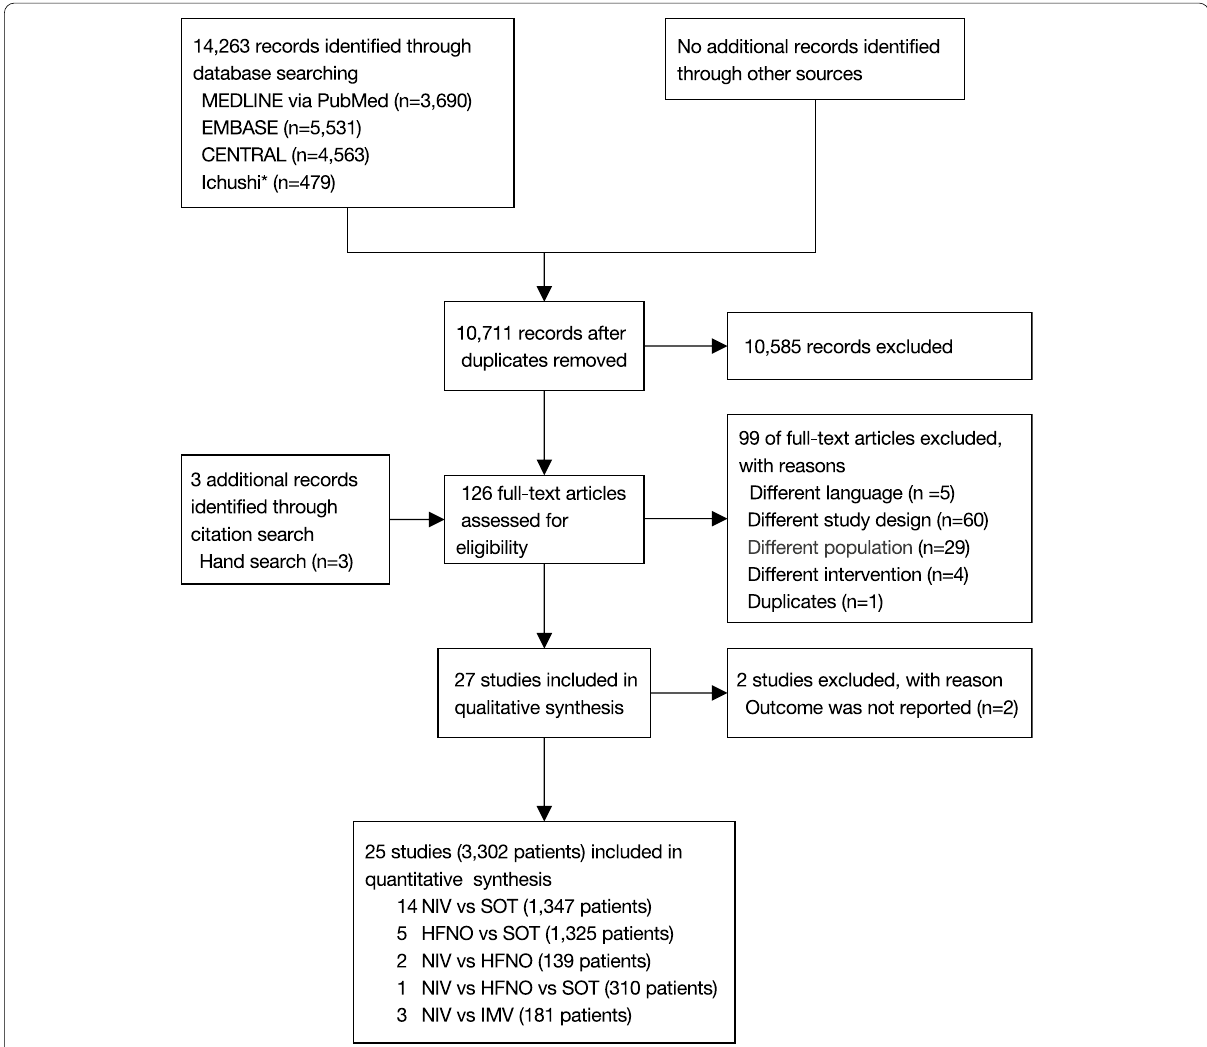
Fig. 1 Flow diagram for the studies included in this review. * Ichushi is a database of Japanese research papers. Abbreviations: CENTRAL (Cochrane Central Register of Controlled Trials); CPAP (continuous positive airway pressure); HFNO (high-flow nasal oxygen); IMV (invasive mechanical ventilation); NIV (noninvasive ventilation); RCT (randomized controlled trial); SOT (standard oxygen